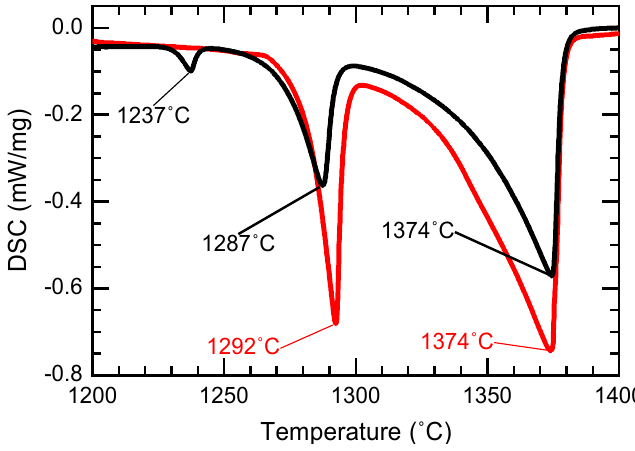
Figure 4. DSC heating traces of as-cast (black trace) and 10 h 1250 °C heat-treated Co-101 (red trace) with peak temperatures labelled.